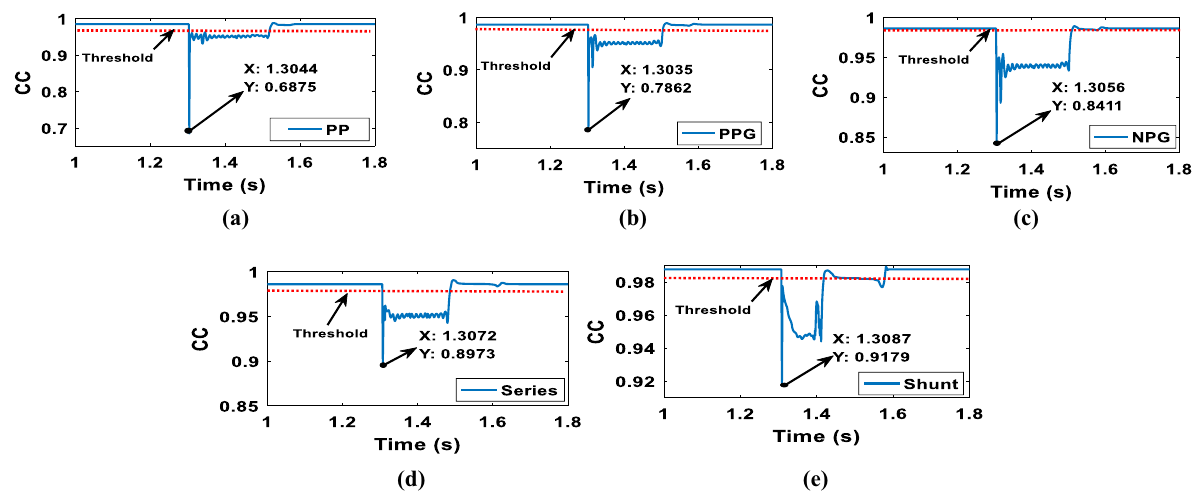
Fig. 15 Fault detection using SMW-PCC at F d